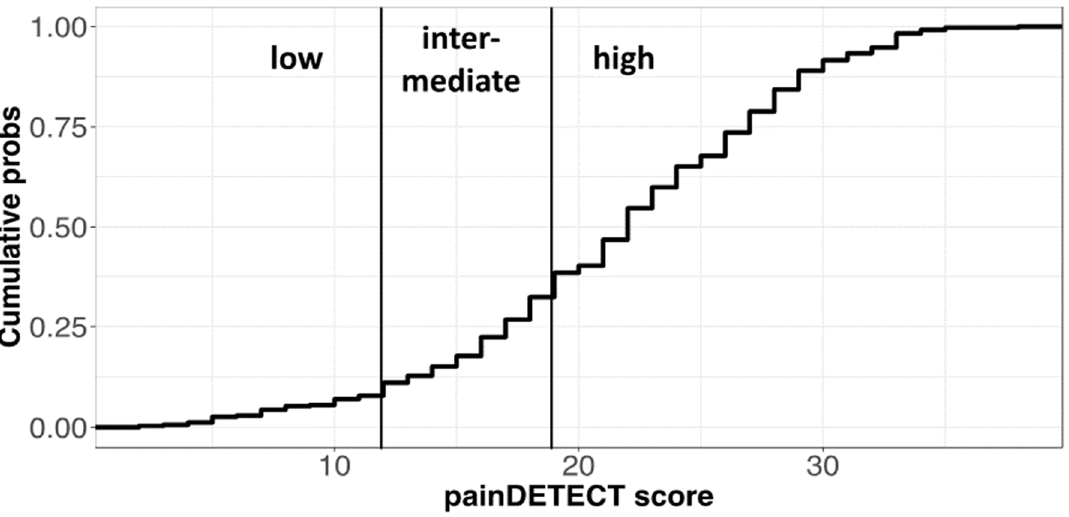
Figure 5. Scores of the PD-Q test and related categories. (Top) Cumulative frequency of scores in the PD-Q scale with cutoffs for pain categories. The relative frequencies of pain categories in the test (low = 0.11; intermediate = 0.21; high = 0.68) are significantly different from uniform distribution according to a chi-square test (n = 344, χ -squared = 188.5, df = 2, p < 2.2 × 10 − 16